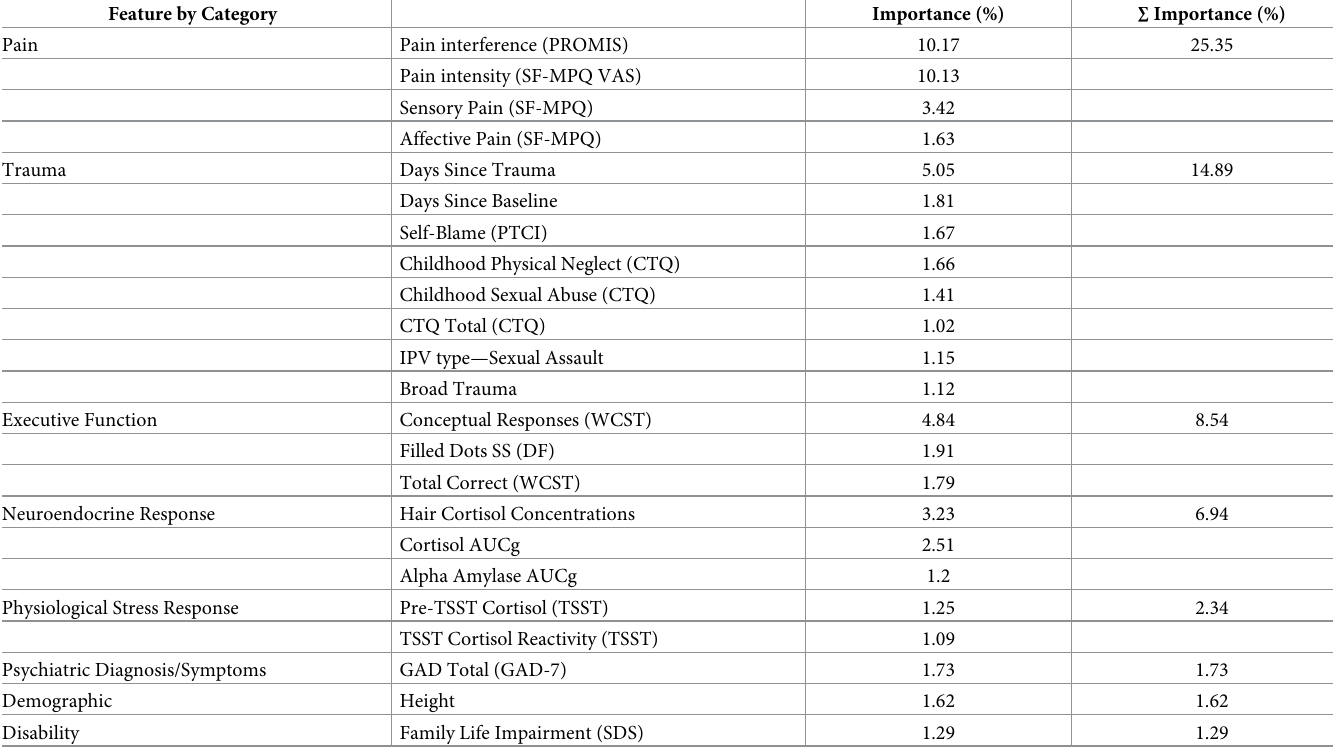
Table 3. Relevant features ( > 1% importance) in gradient boosting machine models predicting SF-MPQ overall. Feature by